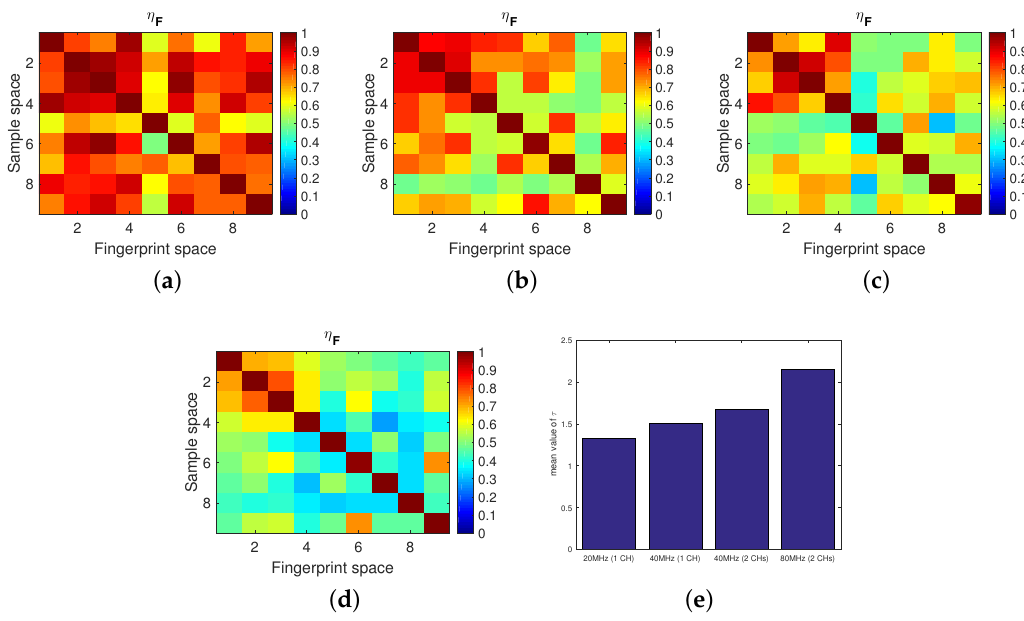
Figure 8. Influence of bandwidth on performance. ( a ) 20 MHz (1 CH). ( b ) 40 MHz (1 CH). ( c ) 40 MHz (2 CHs). ( d ) 80 MHz (2 CHs). ( e ) Spatial-temporal focusing metric